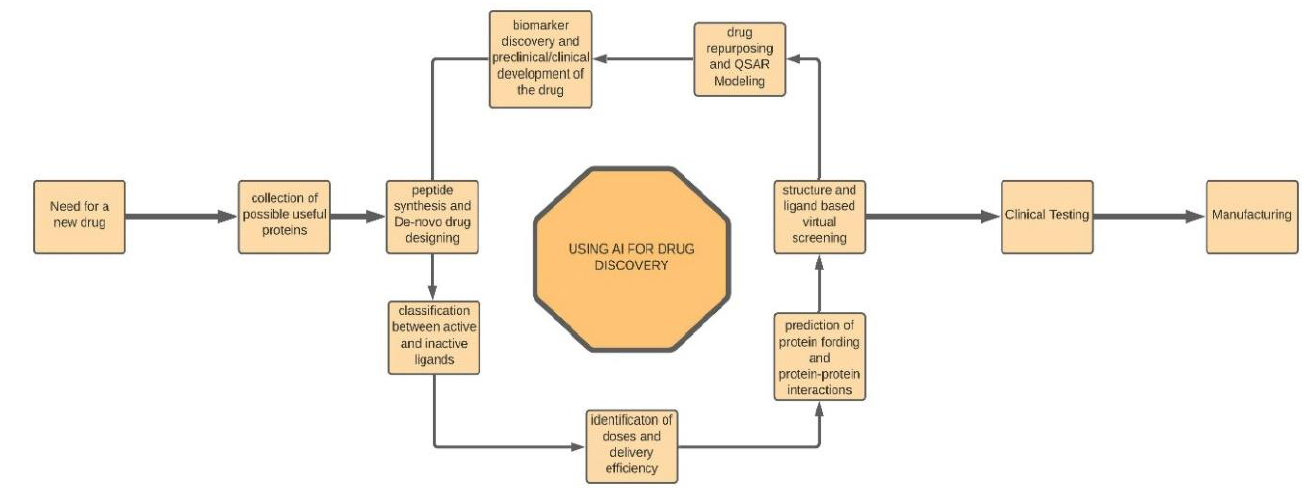
Figure 6. The Process Flow Representation of Drug Discovery using AI.